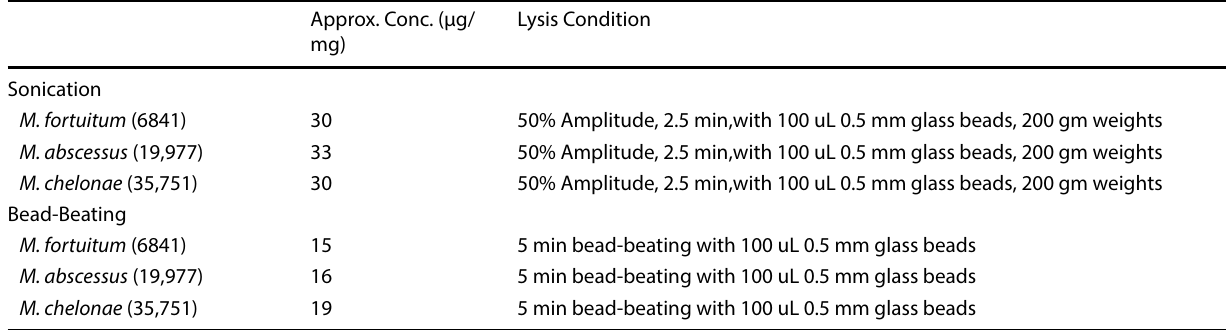
Table 1 Bradford Assay results of proteins extracted with 6 M GuHCl as extraction solvent using Sonication and Bead Beating as lysis method for ~ 5 mg wet